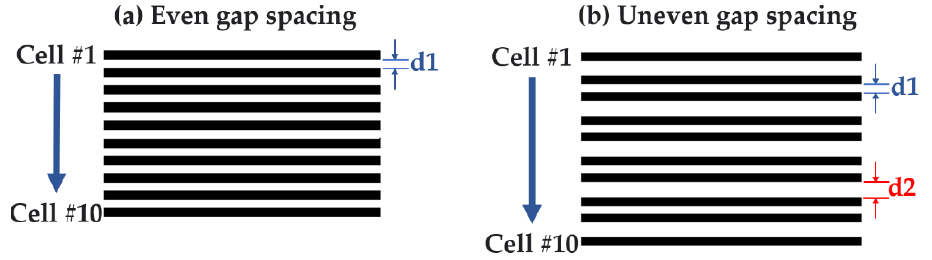
Figure 16. Schematic diagram of the ( a ) even gap spacing—original use case—and ( b ) uneven gap spacing—the proposed design.